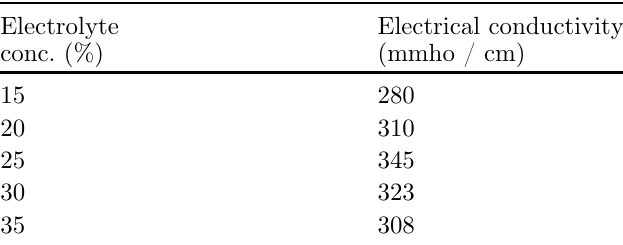
Table 5. Values of electrical conductivity of KOH at different concentrations.